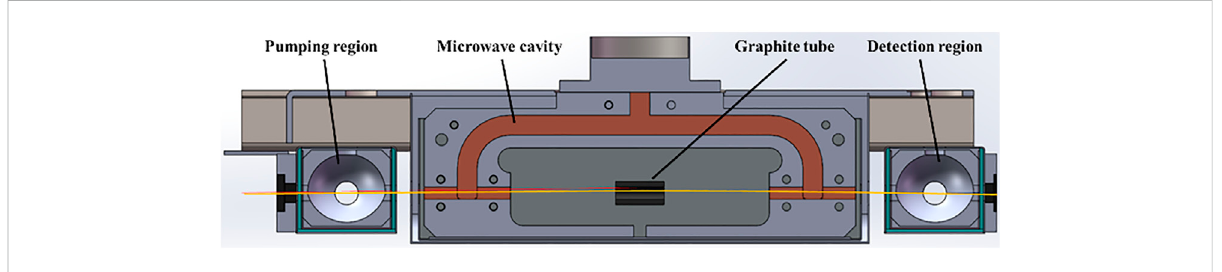
FIGURE 6 Schematic of the trajectories of the pushing light and atomic beam in the cesium beam tube. The red line denotes the laser beam, while the yellow line denotes the atomic beam.